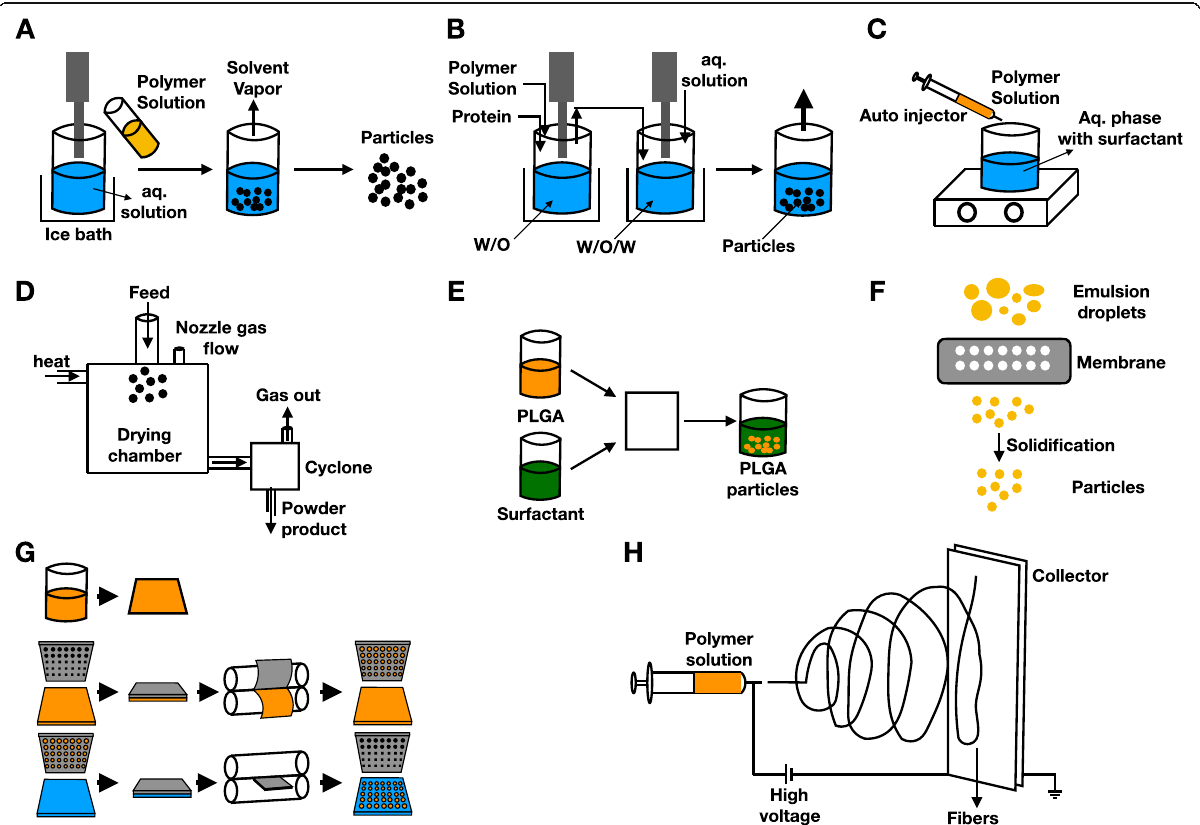
Fig. 5 Classical techniques of polymersomes. a Single emulsion. b Double emulsion. c Nanoprecipitation. d Spray-drying. e Microfluidics. f Extrusion emulsification. g Particle replication in nonwetting template (PRINT). h